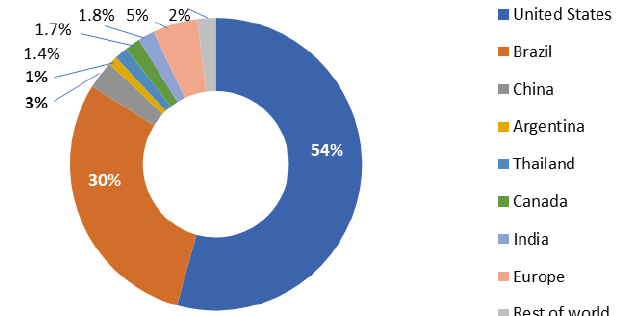
Figure 1. Production of fuel ethanol by country (share of global production) in 2019. Adapted from: 2020 Ethanol Industry Outlook. Renewable Fuel Association (RFA) [11].